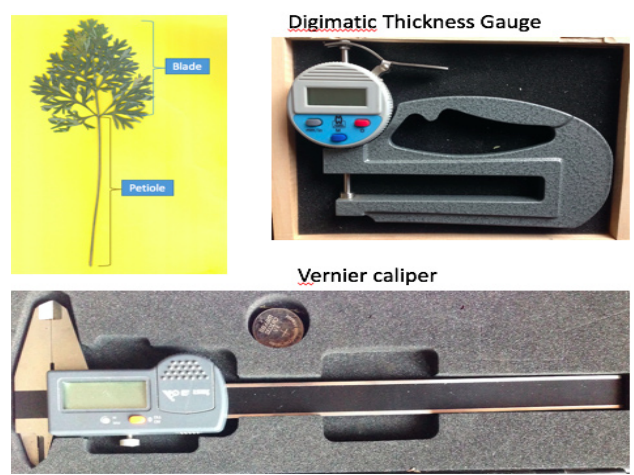
Fig. 1: Herbarium leaf of A. absinthium and devices for leaf